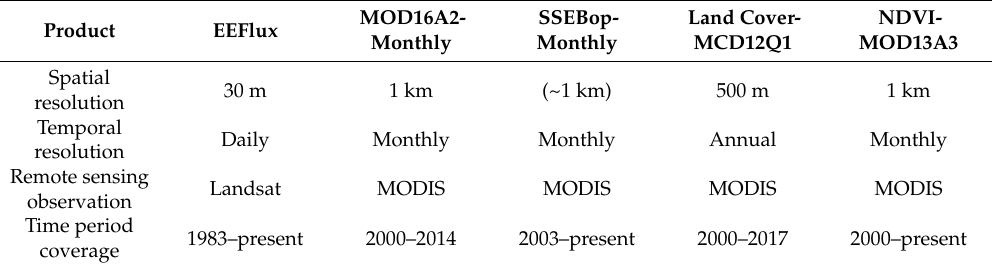
Table 1. Description of the used remote sensing